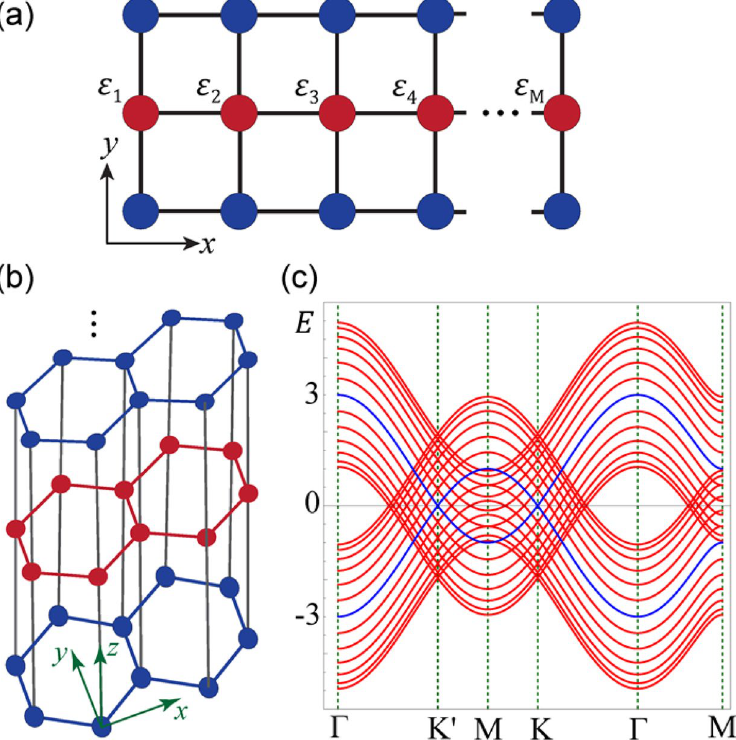
Figure 2. ( a ) A three-chain system: each chain contains M sites and on-site disorder is introduced to the middle chain. ( b ) A multilayer system comprising multiple AA-stacked honeycomb-lattice layers. ( c ) The band structure of the multilayer